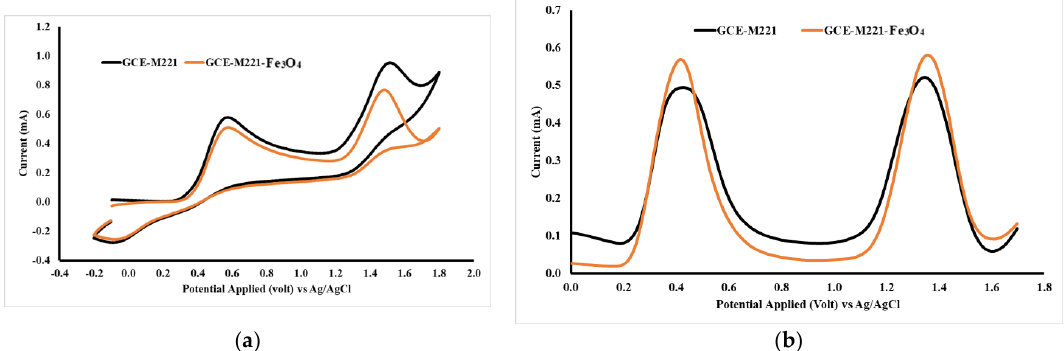
Figure 6. Scanning electron microscopy (SEM) image of membranes M221 ( a ) and M221-Fe 3 O 4 nanoparticles ( b ).